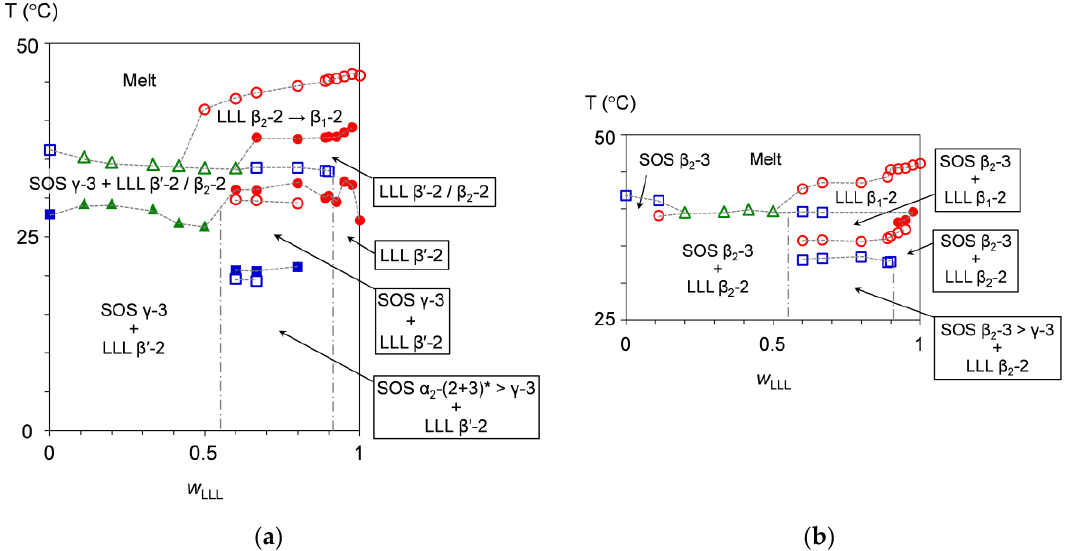
Figure 10. Phase behavior of SOS / LLL as a function of w LLL , depicted for heating at a rate of 5 ◦ C / min: ( a ) without aging; and ( b ) after aging at 25 ◦ C for two weeks. Closed symbols represent phase-transition temperatures due to exothermic e ff ects, and open symbols represent those due to endothermic e ff ects of SOS (blue square), LLL (red circle), and SOS + LLL (green triangle). * Transitional structure of SOS α 2 -(2 + 3) is defined in ref. [50].